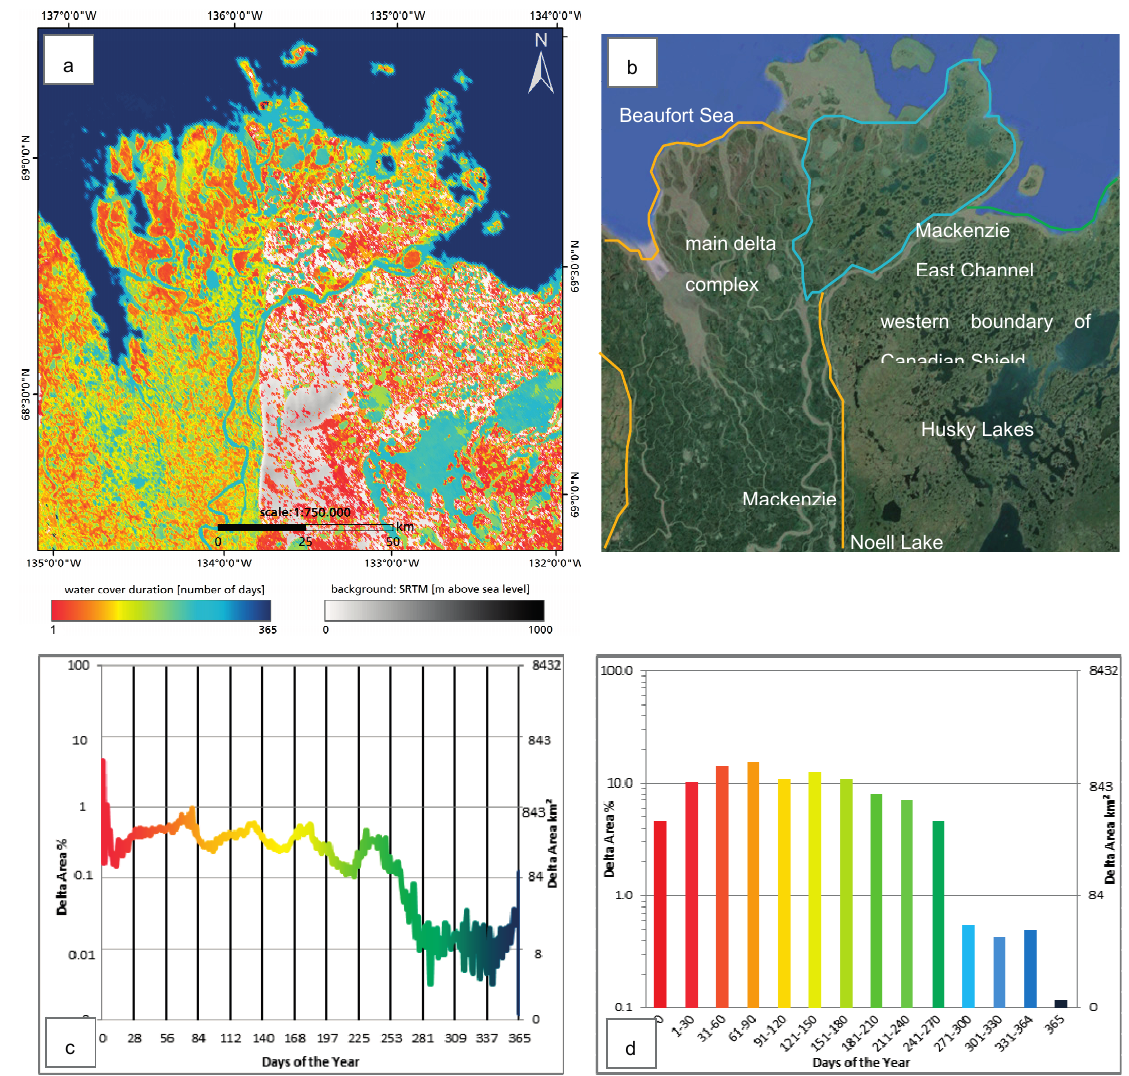
Figure 8. Intra-annual inundation patterns of the Mackenzie Delta Region, Canada, derived from an annual time series of daily temporal resolution for the year 2013. Note that figures c and d represent the main delta complex (within the orange boundary) only. ( a ) intra-annual inundation dynamics, ( b ) optical data for comparison, ( c , d ) quantitative analyses of inundation